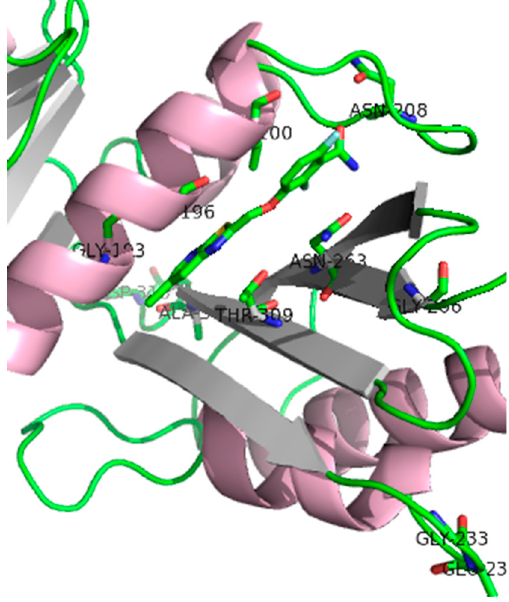
Figure 4. Sa FtsZ in complex with benzamide PC190723 ( 10 ) (PDB entry 4DXD). Residues for which amino acid substitution resistance mutations have been identified are highlighted. It is worth noting that Gly 193 and Gly 196 residues account for about 90% of the resistant isolates [33].